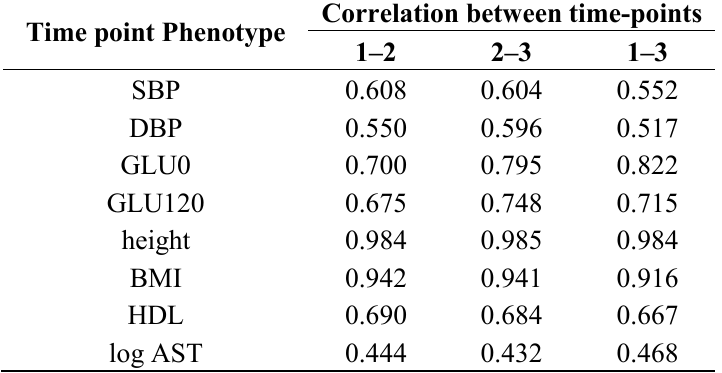
Table 4. Correlations between different time-points for each